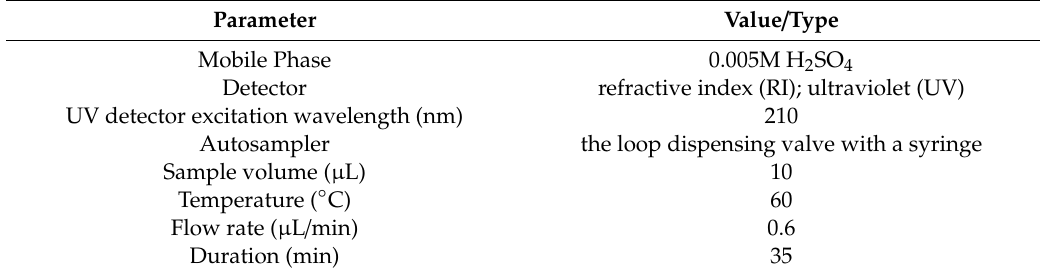
Table 4. Parameters applied in HPLC analysis of organic acid